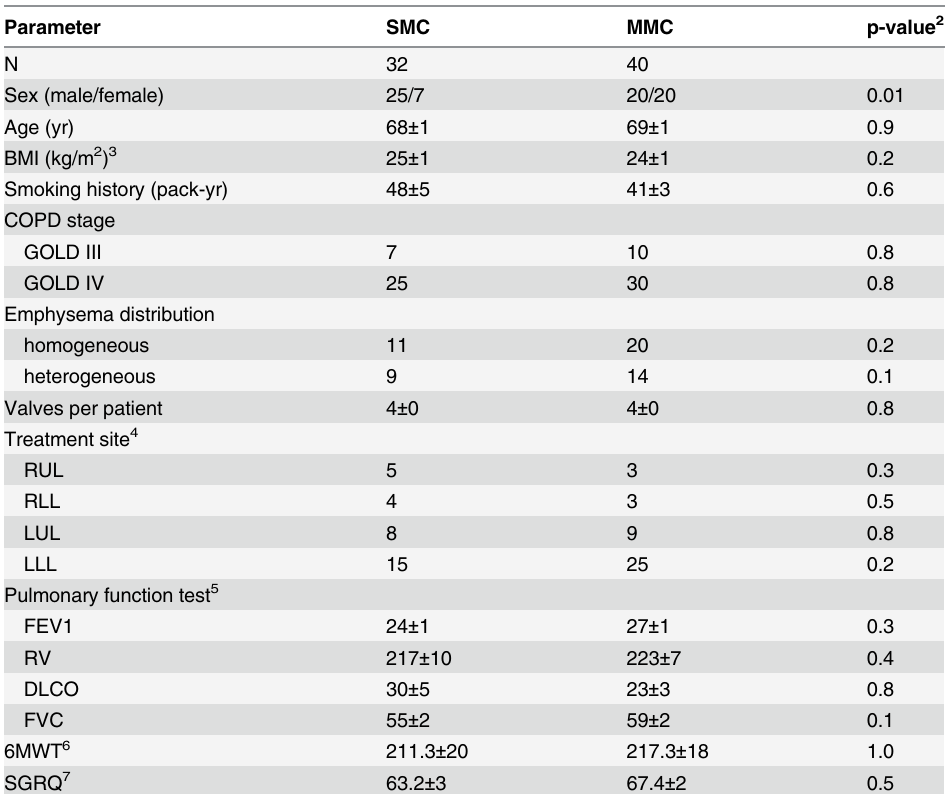
Table 1. Demographic characteristics of the study population 1 .